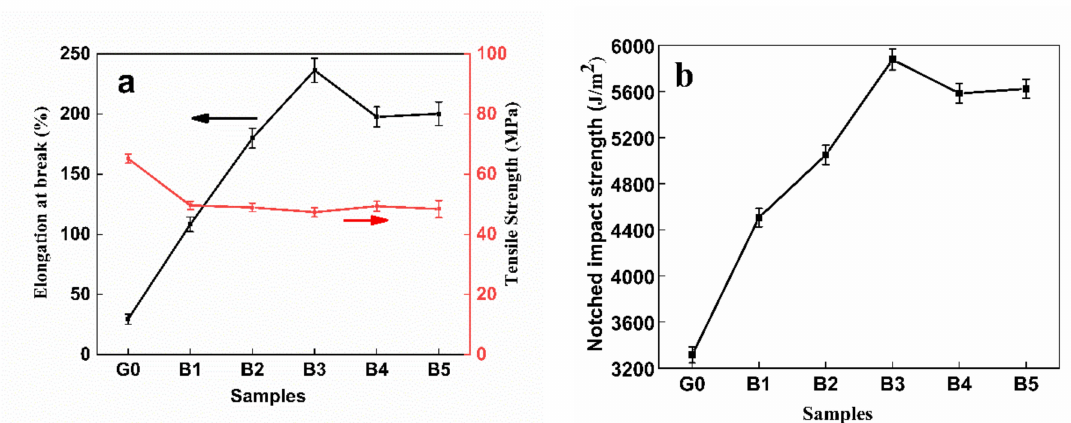
Figure 4. Effect of PLA-g-GMA content on mechanical properties of PLA/PPC/PLA-g-GMA blends